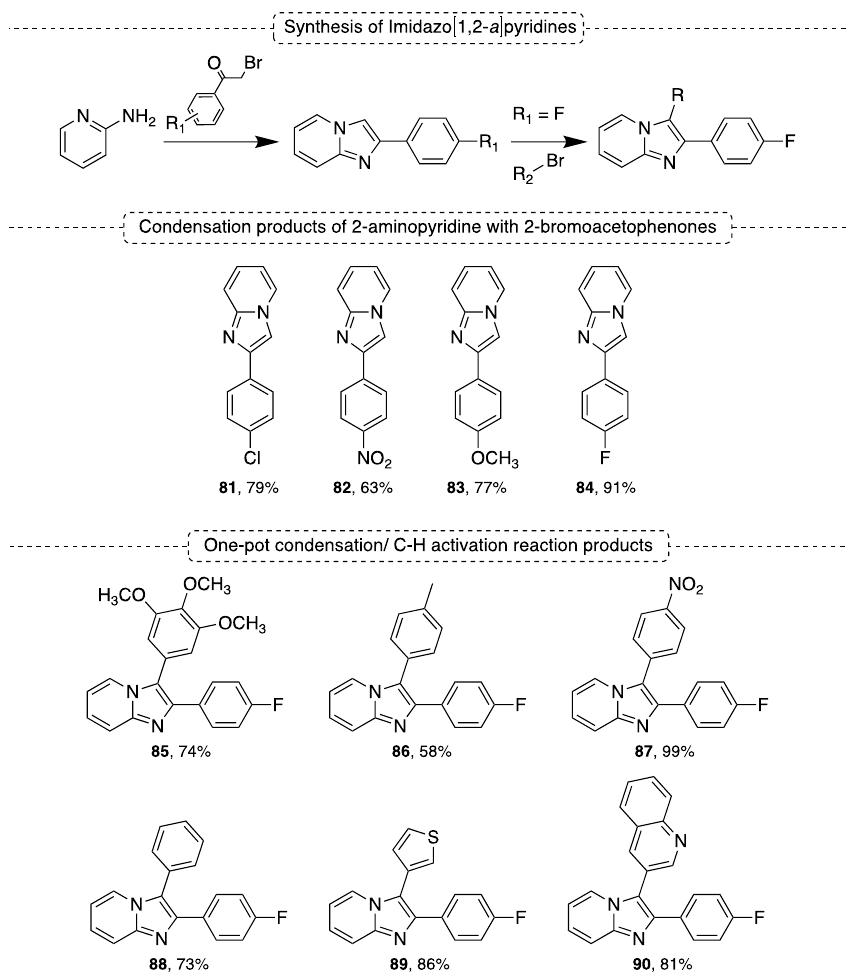
Figure 10. Synthesis of various Imidazo[1,2- a ]pyridines in eucalyptol [120].